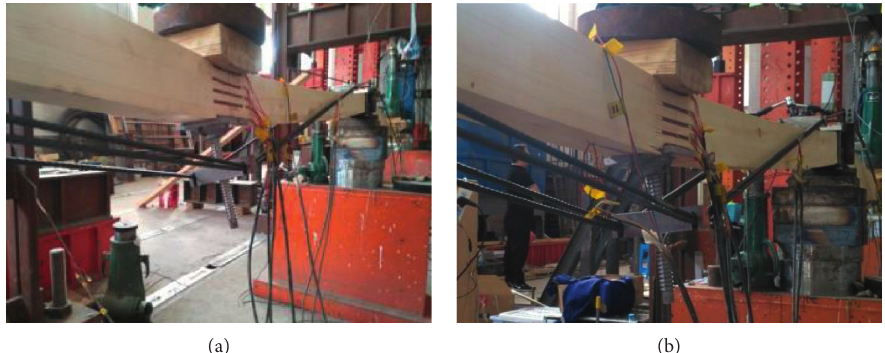
Figure 8: Buckling failure of the Glulam beam. (a) Buckling failure of the L